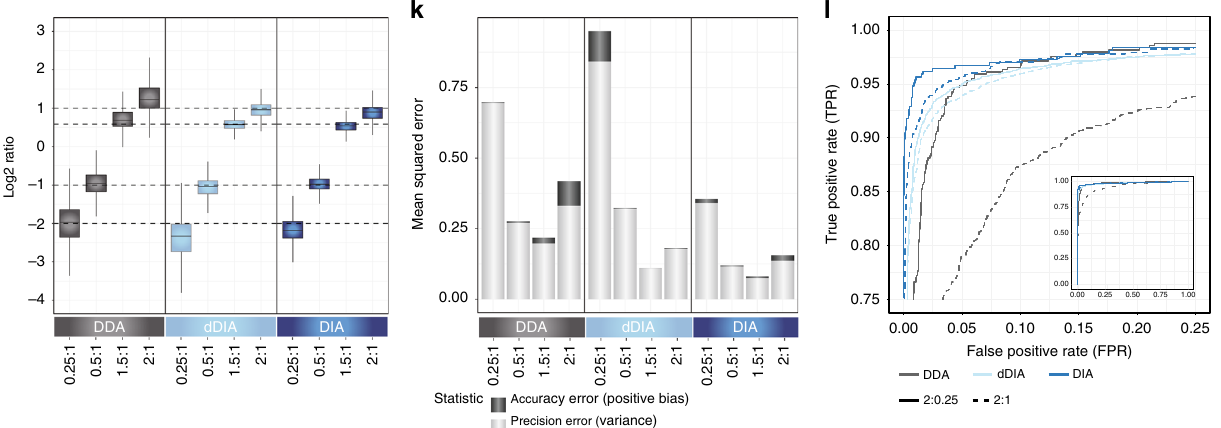
Fig. 1 High-throughput and sensitive phosphoproteomics for DDA and DIA — identi fi cation and quanti fi cation. a Experimental work fl ow for phosphoproteomics. b Comparison of quanti fi ed phosphopeptides with DDA & DIA. c Overlap of phosphopeptides between two replica with DDA. d Overlap of phosphopeptides between two replica with DIA. e Correlation between replicates with DDA. f Correlation between replicates with DIA. g Ions measured in the orbitrap in MS2 scans with DDA and DIA. h Quanti fi ed difference in ions measured in the orbitrap for DDA and DIA. i Experimental work fl ow for evaluation of accuracy and precision of the method. j Boxplot of measured and theoretical ratios for yeast phosphopeptides with DDA and DIA from six independent measurements. Boxes mark the fi rst and third quantile, with the median highlighted as dash, and whiskers marking the minimum/maximum value within 1.5 interquartile range. Outliers are not shown. k Mean squared errors for DDA and DIA from six independent measurements were calculated as a sum of positive bias and variance for each method and all replicates. l Receiver operating characteristic (ROC) curves for DDA and DIA from six independent measurements were calculated by using the d -score from SAM testing as an indicator for signi fi cant regulation. SAM testing for signi fi cantly regulated phosphopeptides was performed at default settings (s0 estimation automatic). ROC plots are presented as zoomed- in excerpts from the total plots, shown on the lower right each. Source data for this fi gure are provided as a Source Data fi le. fragmentation with maximum injection time of 22 ms (Supple- provides the highest number of data points per peak and hence mentary Fig. 1E). Another important measure for evaluating best quanti fi cation (Supplementary Fig. 1F). quantitative accuracy of DIA acquisition methods is the number Using this optimized DIA method with 15 min LC gradients, of data points measured across the elution pro fi les for precursors we identi fi ed almost three times as many elution group identi fi ed. Analyzing this for the different DIA acquisition precursors and twice as many phosphopeptides compared to methods reveals that the shortest DIA scan cycle time of 2 s the number of DDA peptide-spectrum matches and NATURE COMMUNICATIONS| (2020) 11:787